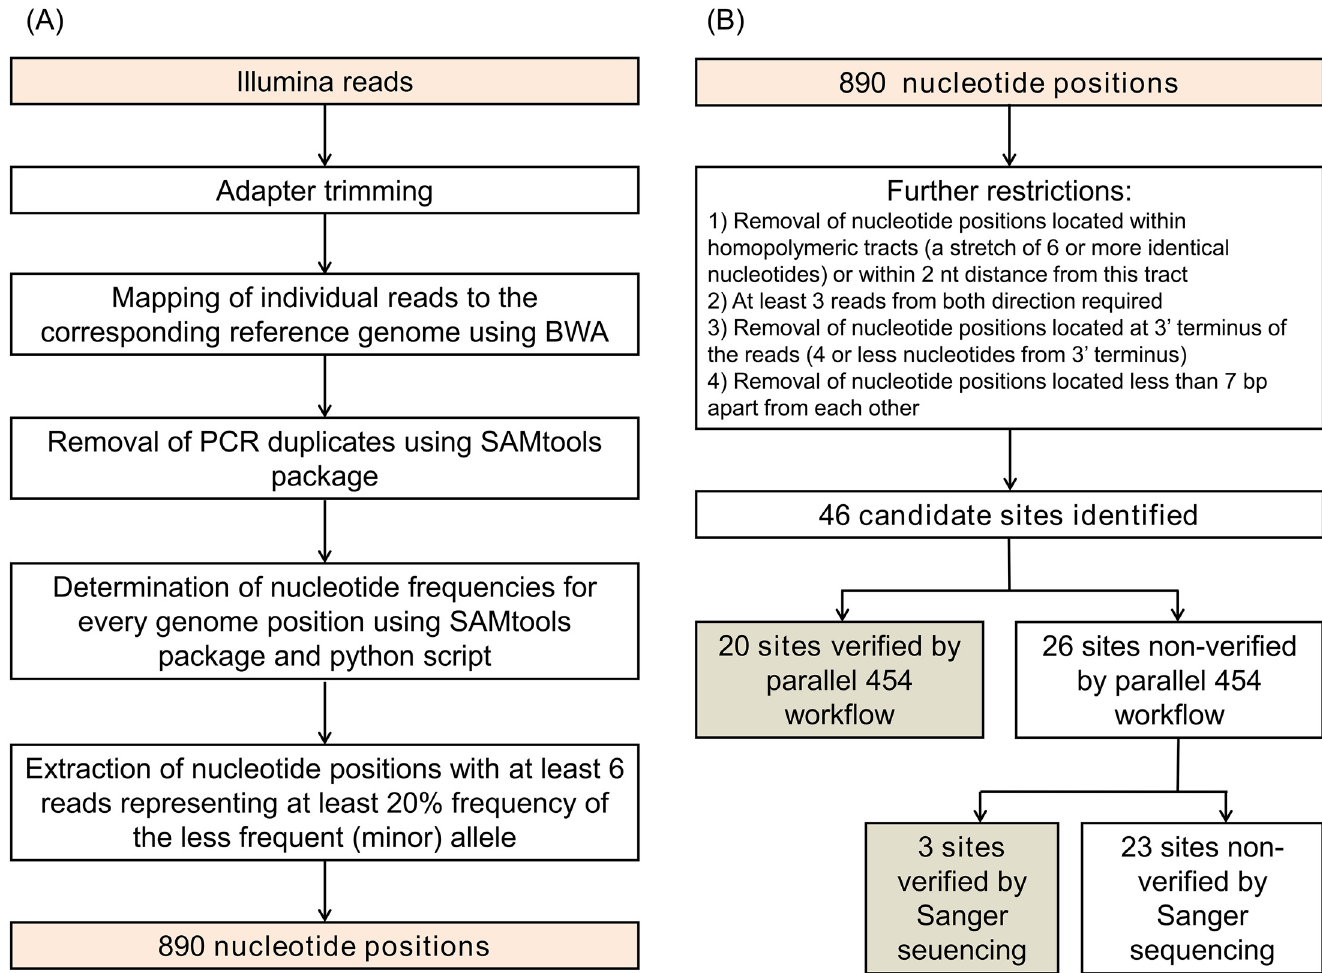
Fig 1. Data analysis workflow. (A) An automated identification pipeline and optimization process. (B) An application of further restrictions and verification of identified putative